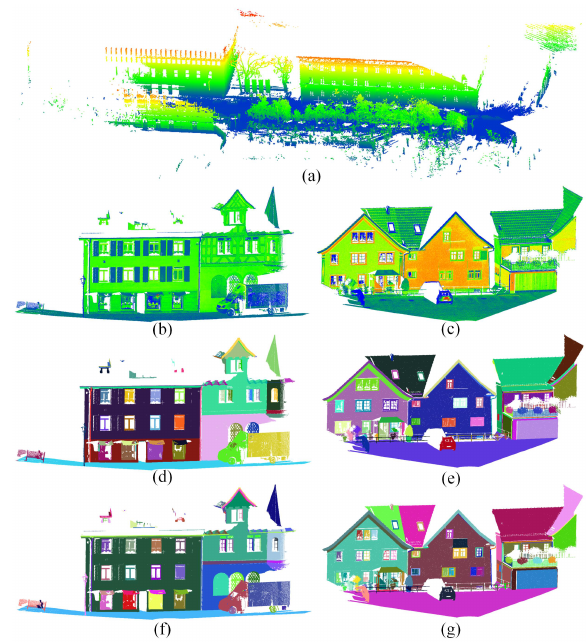
Figure 5. Testing datasets. Original point clouds of (a) Arcisstrasse, (b) St. Gallen, and (c) Town square. Reference 1 of (d) St. Gallen and (e) Town Square. Reference 2 of (f) St. Gallen and (g) Town